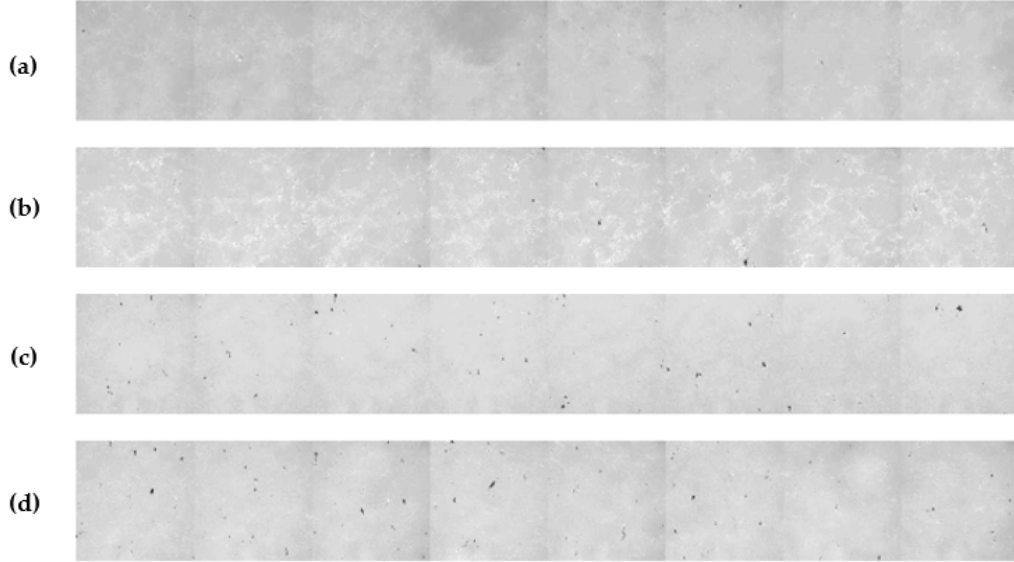
Figure 1. Contact images of ( a ) brand-new pad; followed by pads broken-in for 30 min with ( b ) EHWA disc at 2.7 kg f , ( c ) Abrasive Technology Incorporated (ABT) disc at 2.7 kg f and ( d ) ABT disc at 0.9 kg f .